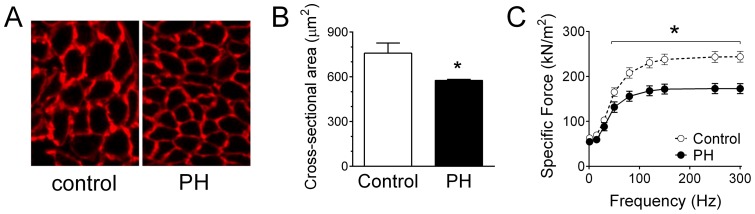
Diaphragm fiber cross sectional area and isometric force are decreased in mice with pulmonary hypertension (PH).A) Cross sections taken from diaphragm muscle fiber bundles of sample control and PH mice. B) Diaphragm fiber cross sectional area of 200–300 fibers per muscle, from 3–4 mice per group. C) Specific Force, force normalized to bundle cross-sectional area. Data are from diaphragm bundles of controls and mice receiving monocrotaline for 6–8 weeks to induce PH (N = 10/group). * P<0.05 for PH vs. control.